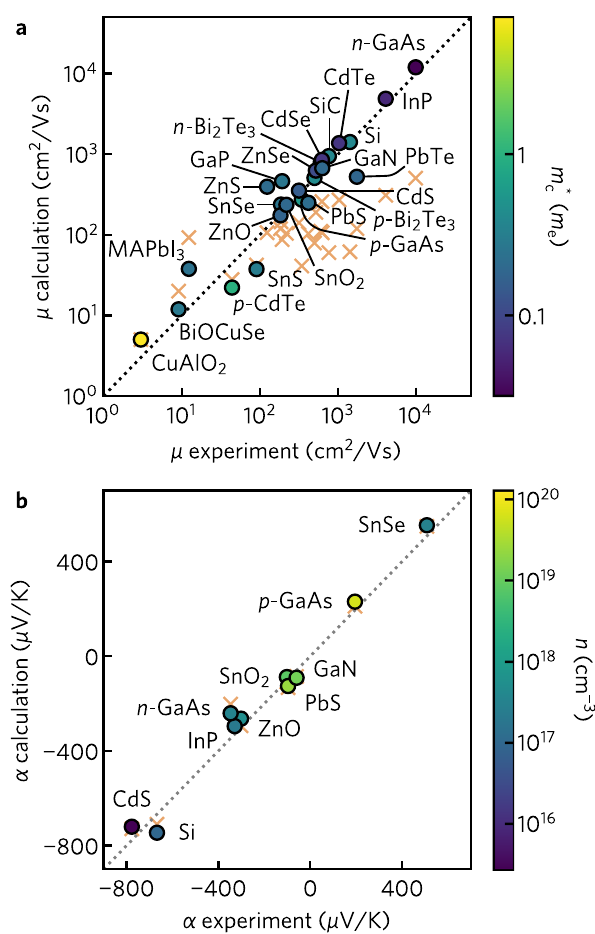
Fig. 4 Calculated mobility and Seebeck coef fi cient against experiment. a Comparison of carrier mobilities, μ , at 300 K between calculations and experiments, with points colored by the conductivity effective mass m (cid:3) c . b Comparison of Seebeck coef fi cients, α , at 300 K between calculations and experiments, with points colored by the majority carrier concentration n . For Si and CdS we compare directly to the diffusive component of Seebeck coef fi cient only. CH 3 NH 3 PbI 3 has been abbreviated as MAPbI 3 . In ( a ) and ( b ), orange crosses indicate results computed using a constant relaxation time of 10 fs. Detailed temperature and carrier concentration results for each material are provided in Supplementary Figs. 8 and